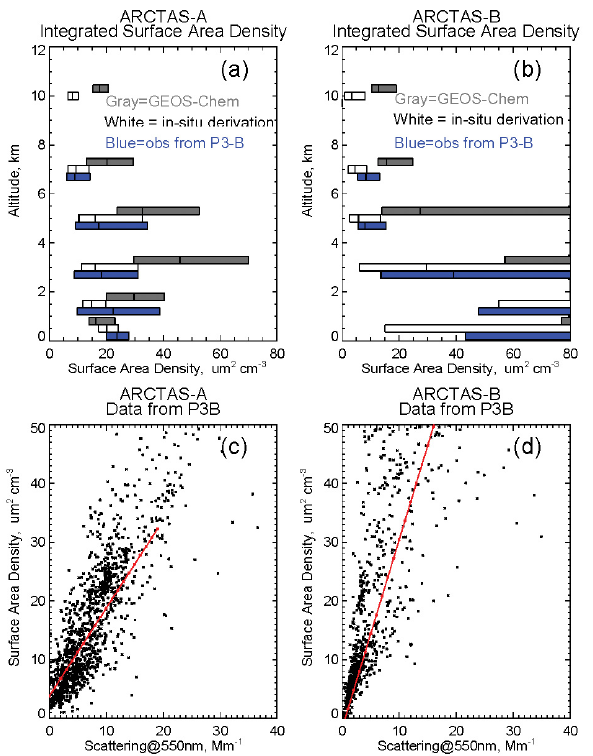
Fig. 16. Integrated surface area density (SAD) and scattering @550 nm during ARCTAS. Altitude profiles of SAD are shown for (a) ARCTAS-A and (b) ARCTAS-B. Bars show values of SAD ob- tained from P3-B observations, from derivations using a correla- tion to DC-8 observations of scattering @550nm, and from calcu- lations using the GEOS-Chem model. Bar plots are as described in Fig. 2. The correlation between measurements of SAD and scatter- ing @550nm from the P3-B are shown for (c) ARCTAS-A and (d) ARCTAS-B.